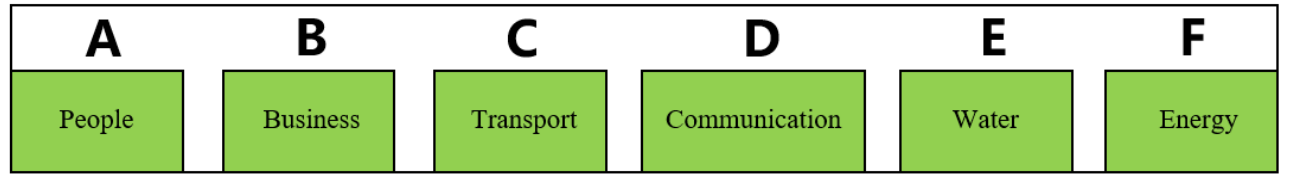
Figure 6. The selected chain from IBM.